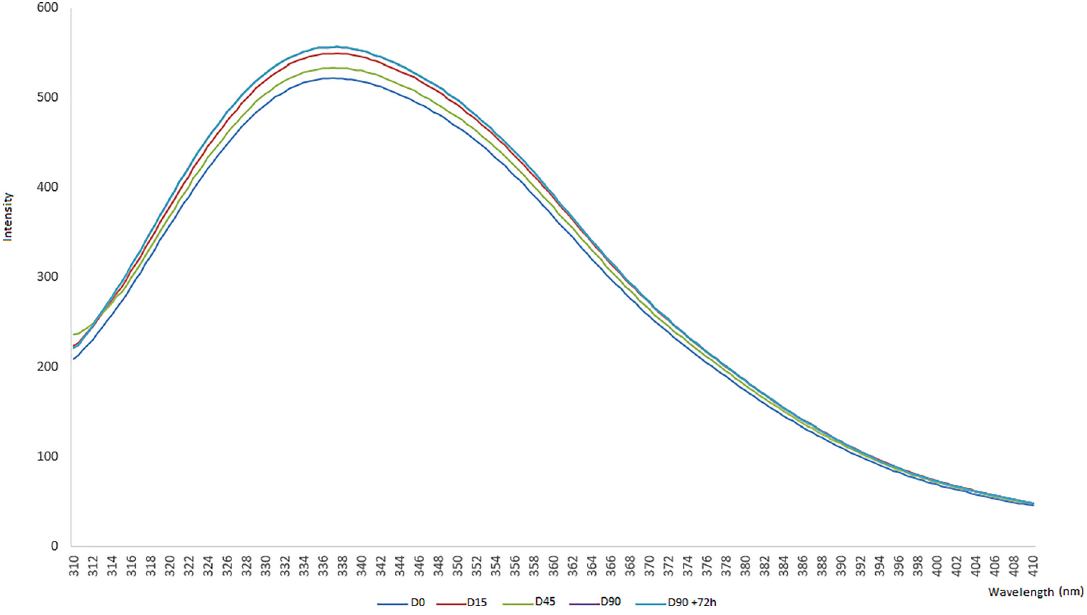
Figure 2: Fluorescence emission spectrum of Bevacizumab diluted to 1.4 mg/mL (up to 90 days of storage at 4 ° C followed by 72 h at 25 ° C).